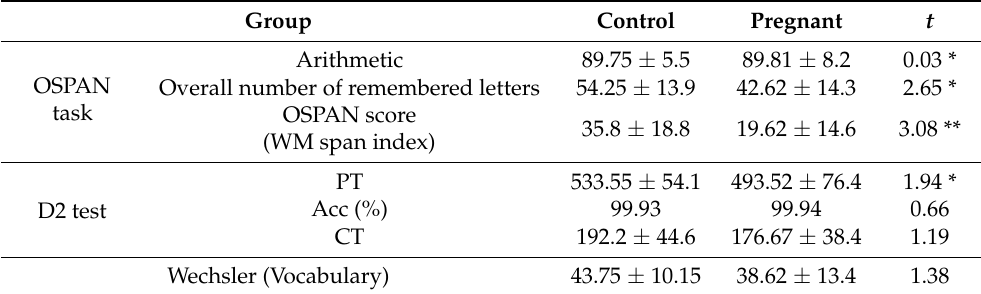
Table 1. Cognitive performance of pregnant women and non-pregnant controls. Group Control Pregnant t OSPAN task